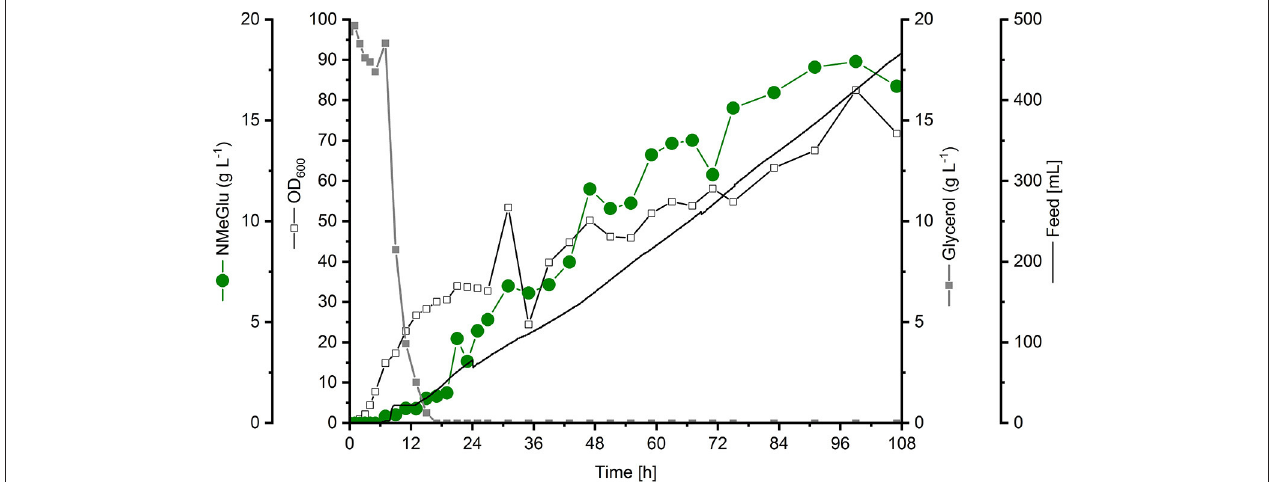
FIGURE 3 | Fed-batch cultivation of P. putida NMG3 using HSG medium supplemented with 100m M MMA. Starting with an initial volume of 2L, the feed solution was coupled to the rDOS value. The feed volume is indicated by the black line. After 24 and 48h 100 m M MMA was added. The biomass formation (black open squares) and concentrations of glycerol (gray closed squares) and NMeGlu (green closed circles) are shown. All concentrations, the feed volume and the biomass formation were related to the initial volume.